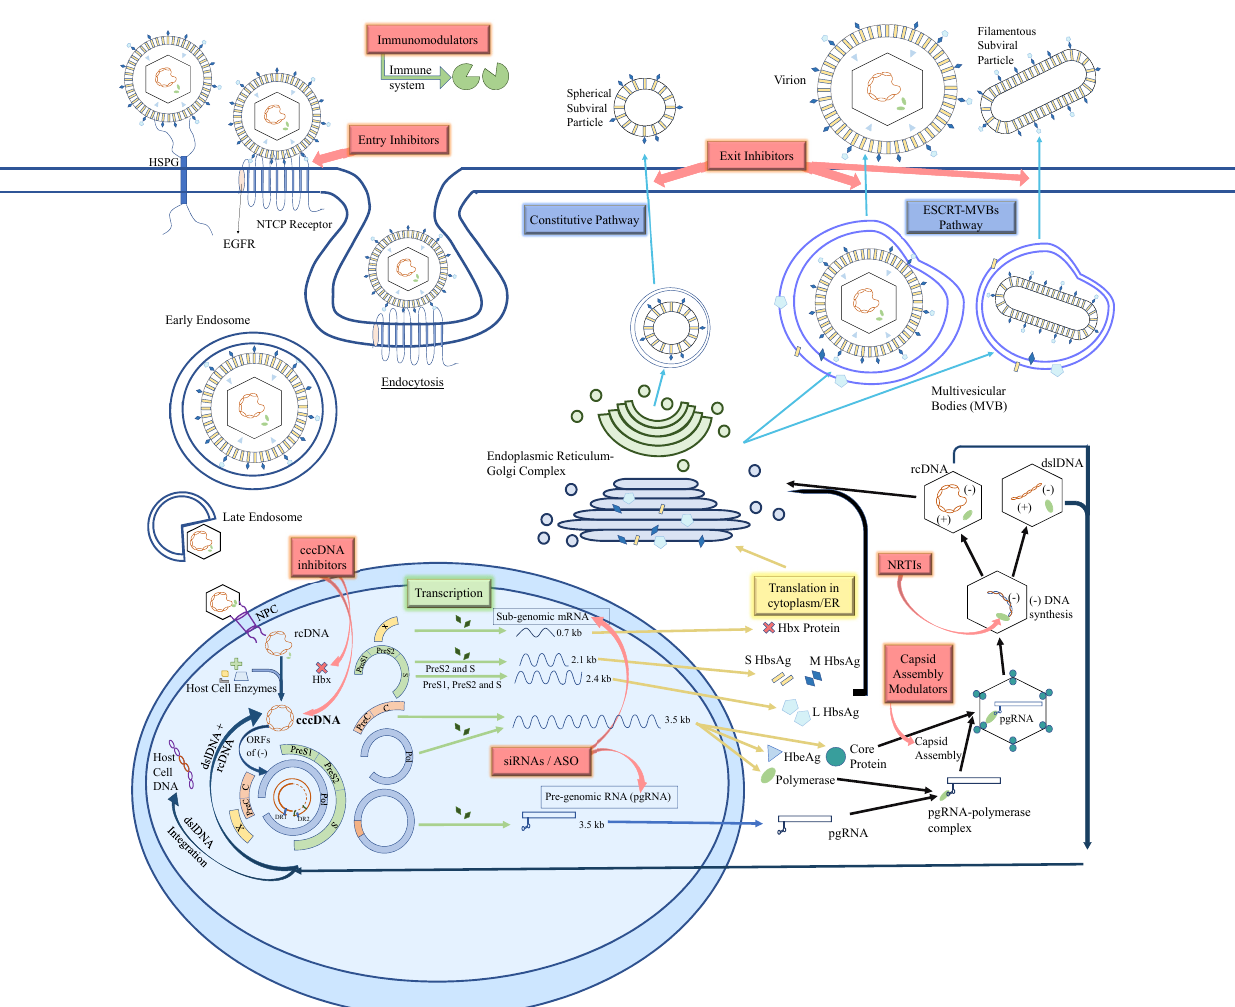
Figure 2. HBV life cycle in a hepatocyte. Entry inhibitors target the NTCP receptor on hepatocytes and hence prevent the entry of virion into the cell altogether. cccDNA inhibitors either act by targeting the HBx protein which leads to smc5/6 degrading cccDNA or by using the CRISPR/Cas9 nucleases system to break apart the cccDNA. Silencing RNAs (siRNAs) play a role in the destruction of newly formed RNAs. Antisense oligonucleotides (ASO) work against the mRNAs and stop them from reaching the translation step. Capsid assembly modulators cause the production of defected or empty nucleocapsids which fail to further produce new cccDNA or virions. Nucleic acid polymers (NAPs) block the assembly and the secretion of spherical SVP. The release of subviral filaments and virions is not affected [12]. Immunomodulators boost the immune system to attack the virus. HSPG: Heparan Sulfate Proteoglycans, NTCP: Sodium Taurocholate Cotransporting Polypeptide, EGFR: Epidermal Growth Factor Receptor, NPS: Nuclear Pore Complex, rcDNA: relaxed circular DNA, cccDNA: covalently closed circular DNA, ORFs: Open Reading Frames, dslDNA: double-stranded linear DNA, siRNAs: small interfering RNA, ASO: Anti-sense Oligonucleotide, S, M, L HBsAg: Small, Medium, Large HBsAg, ER: Endoplasmic Reticulum, ESCRT-MVBs pathway: Endosomal Sorting Complex Required for